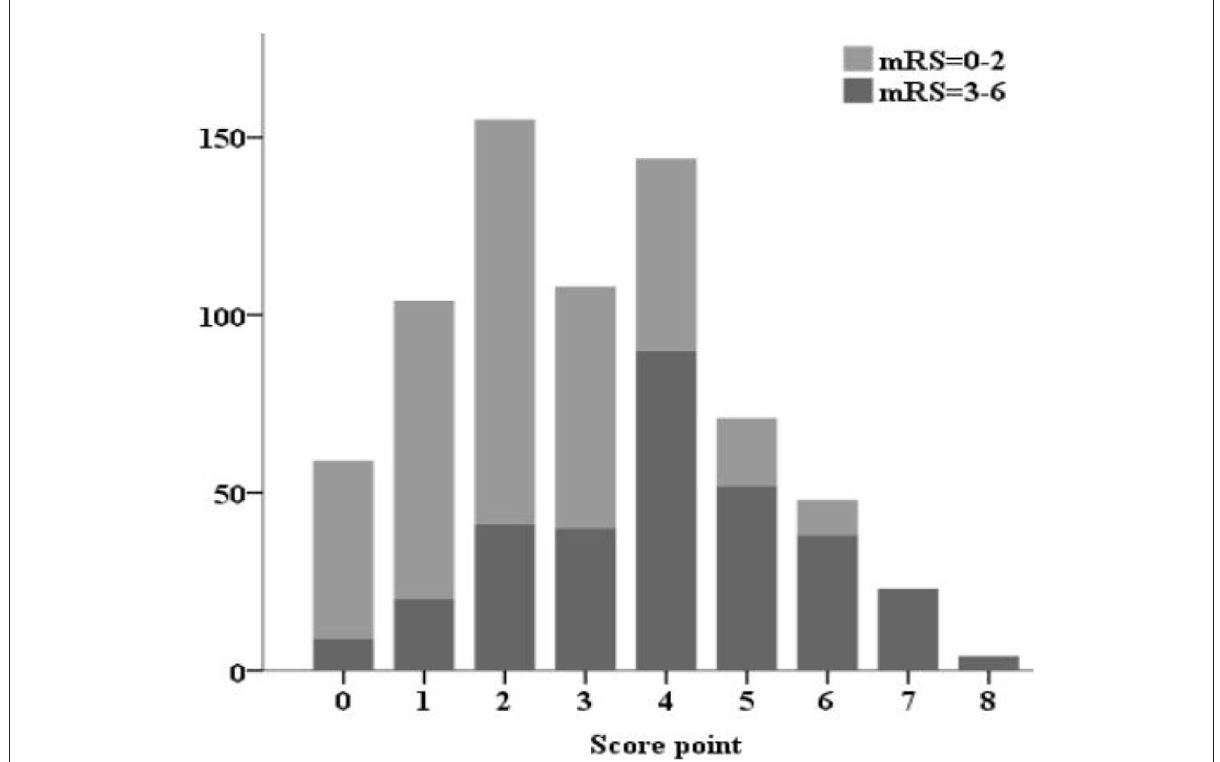
FIGURE3 Proportion of patients with good and poor outcomes for each SON2A2